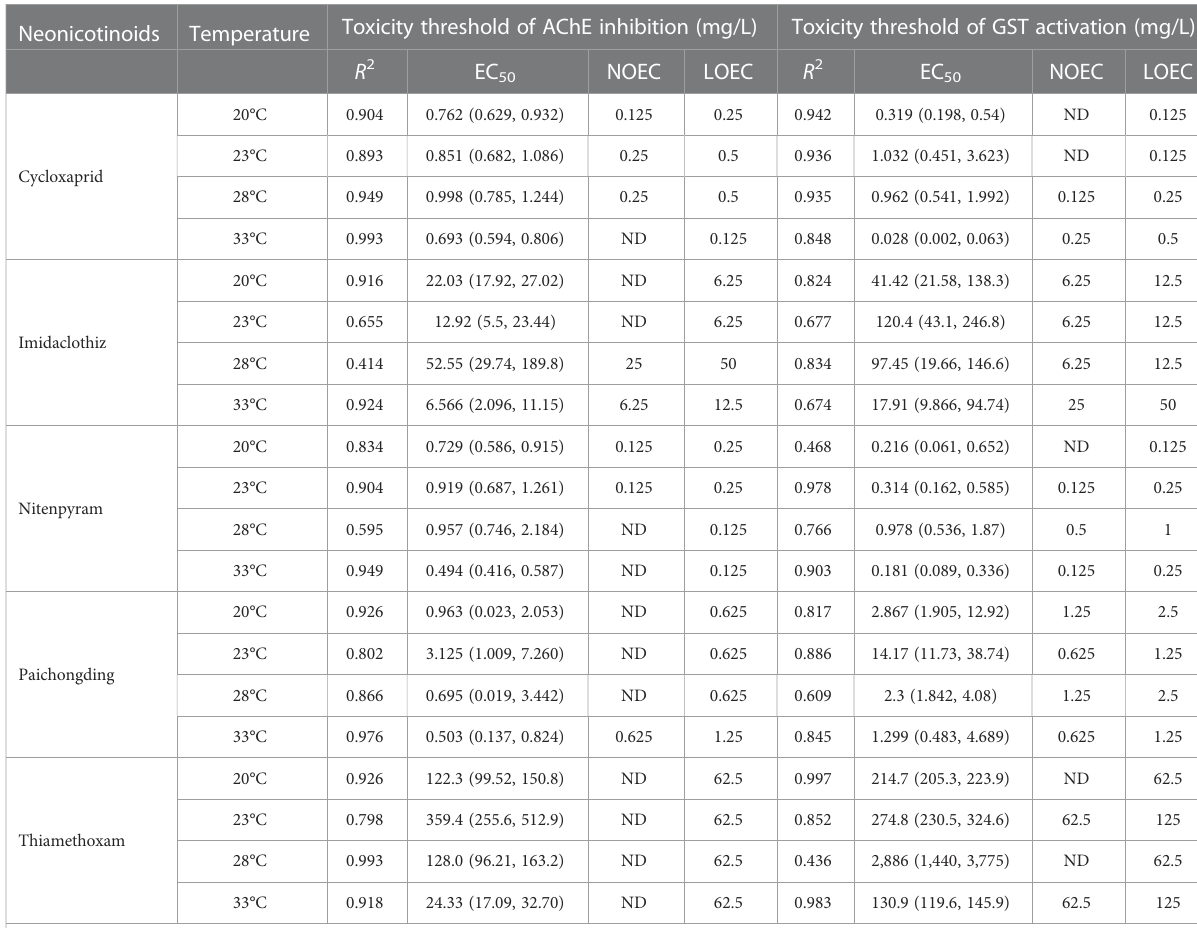
TABLE 2 Toxicity threshold of AChE inhibition and GST activation (EC 50 , NOEC, LOEC, mg/L) of fi ve neonicotinoids under different temperature conditions.